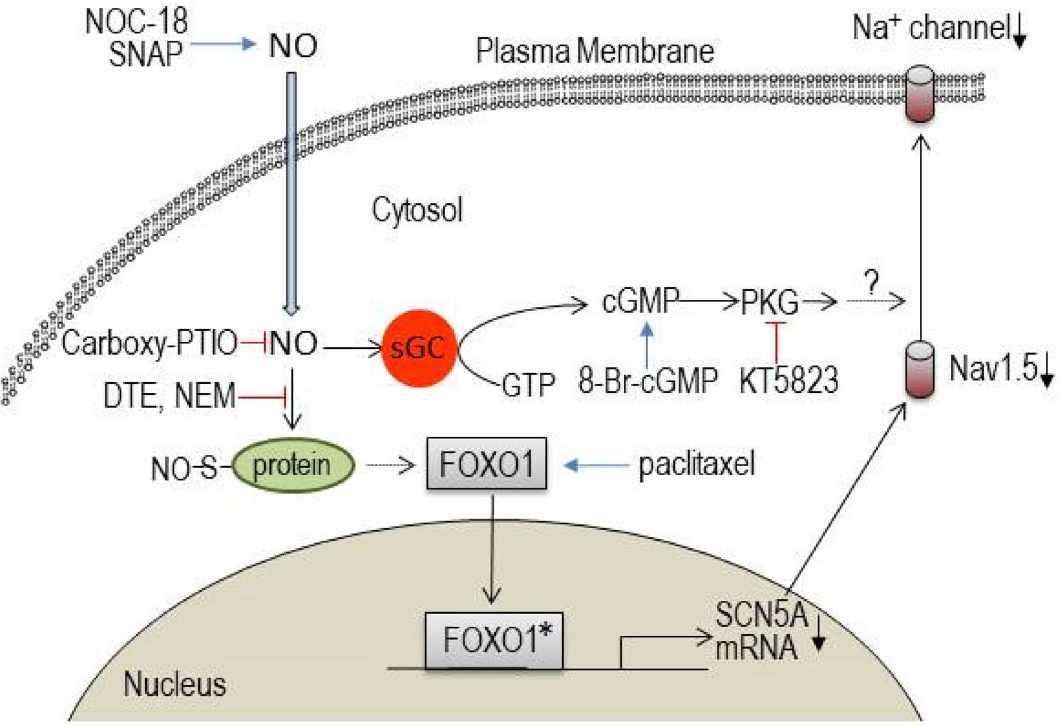
Figure 8. The current hypothesis regarding NO-mediated downregulation of the Na + channel. NO is suggested to act through a suppressor gene FOXO1 for SCN5A transcription. FOXO1*: activated form of